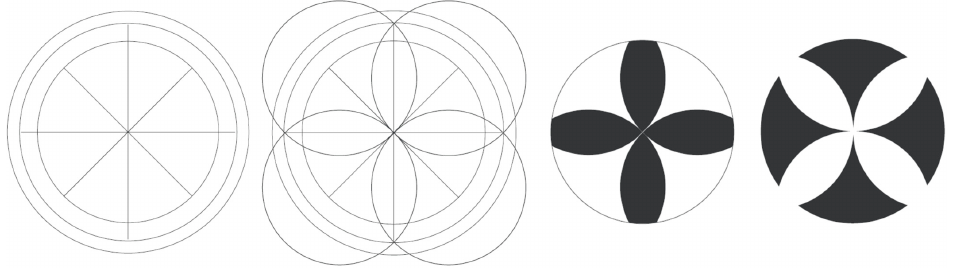
Figure 9. Spatial Orientation.